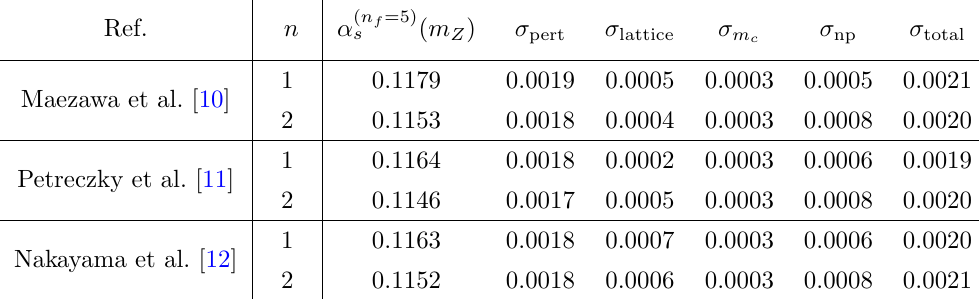
Table 10 . (cid:11) ( n f =5) s ( m Z ) determination from ratios of charm pseudo-scalar correlator moments R P;n . The (cid:12)rst column shows from which reference the lattice results are taken, the second which c ratio has been used, the third corresponds to the central value, fourth to seventh provide the various component of the uncertainty: scale variation ( (cid:27) pert ), lattice ( (cid:27) lattice ), charm mass ( (cid:27) m condensate ( (cid:27) np ), which are added in quadrature in the last column ( (cid:27) total